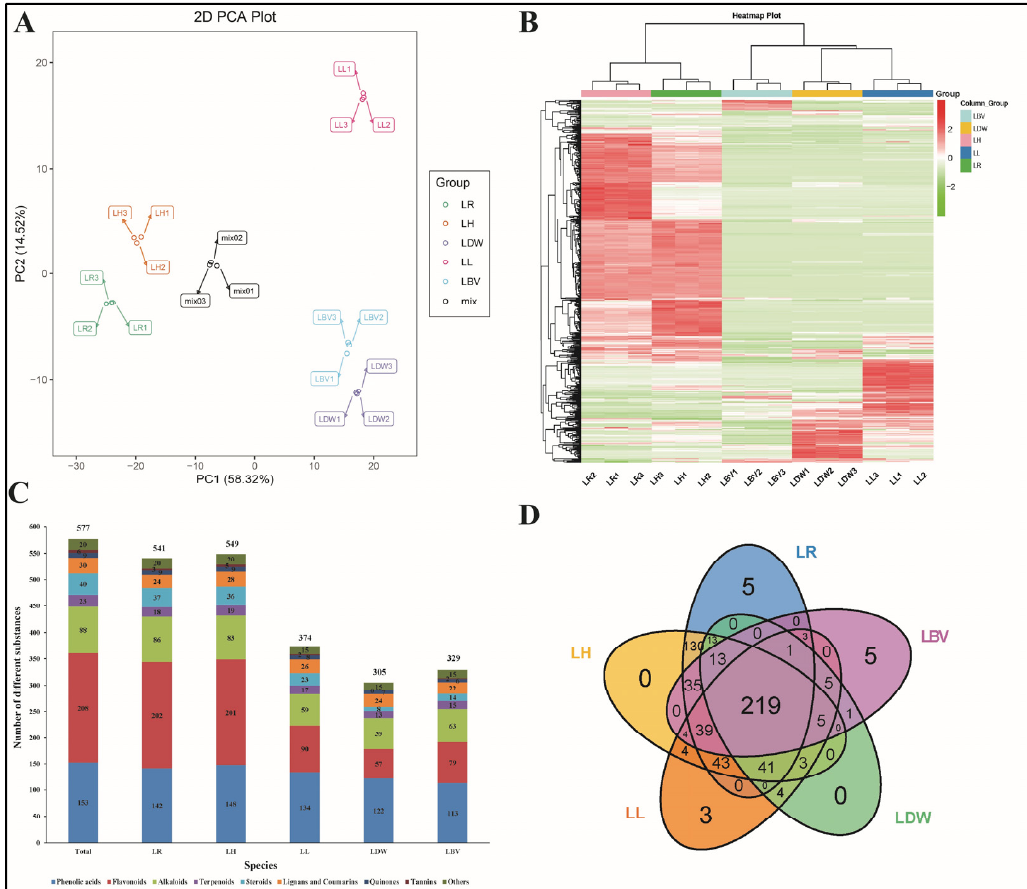
Figure 2. Overview of metabolites analysis detected in five lily species. LR: L. regale , LH: L. henryi , LL: L. lancifolium , LDW: L. davidii var. willmottiae , LBV: L. brownii var. viridulum . ( A ) Principal component analysis of the relative of metabolites for LR, LH, LL, LDW and LBV. ( B ) Cluster heatmap of metabolite content in different samples. ( C ) Distribution of substances in different materials. ( D ) Venn diagram of metabolite distribution in different materials.